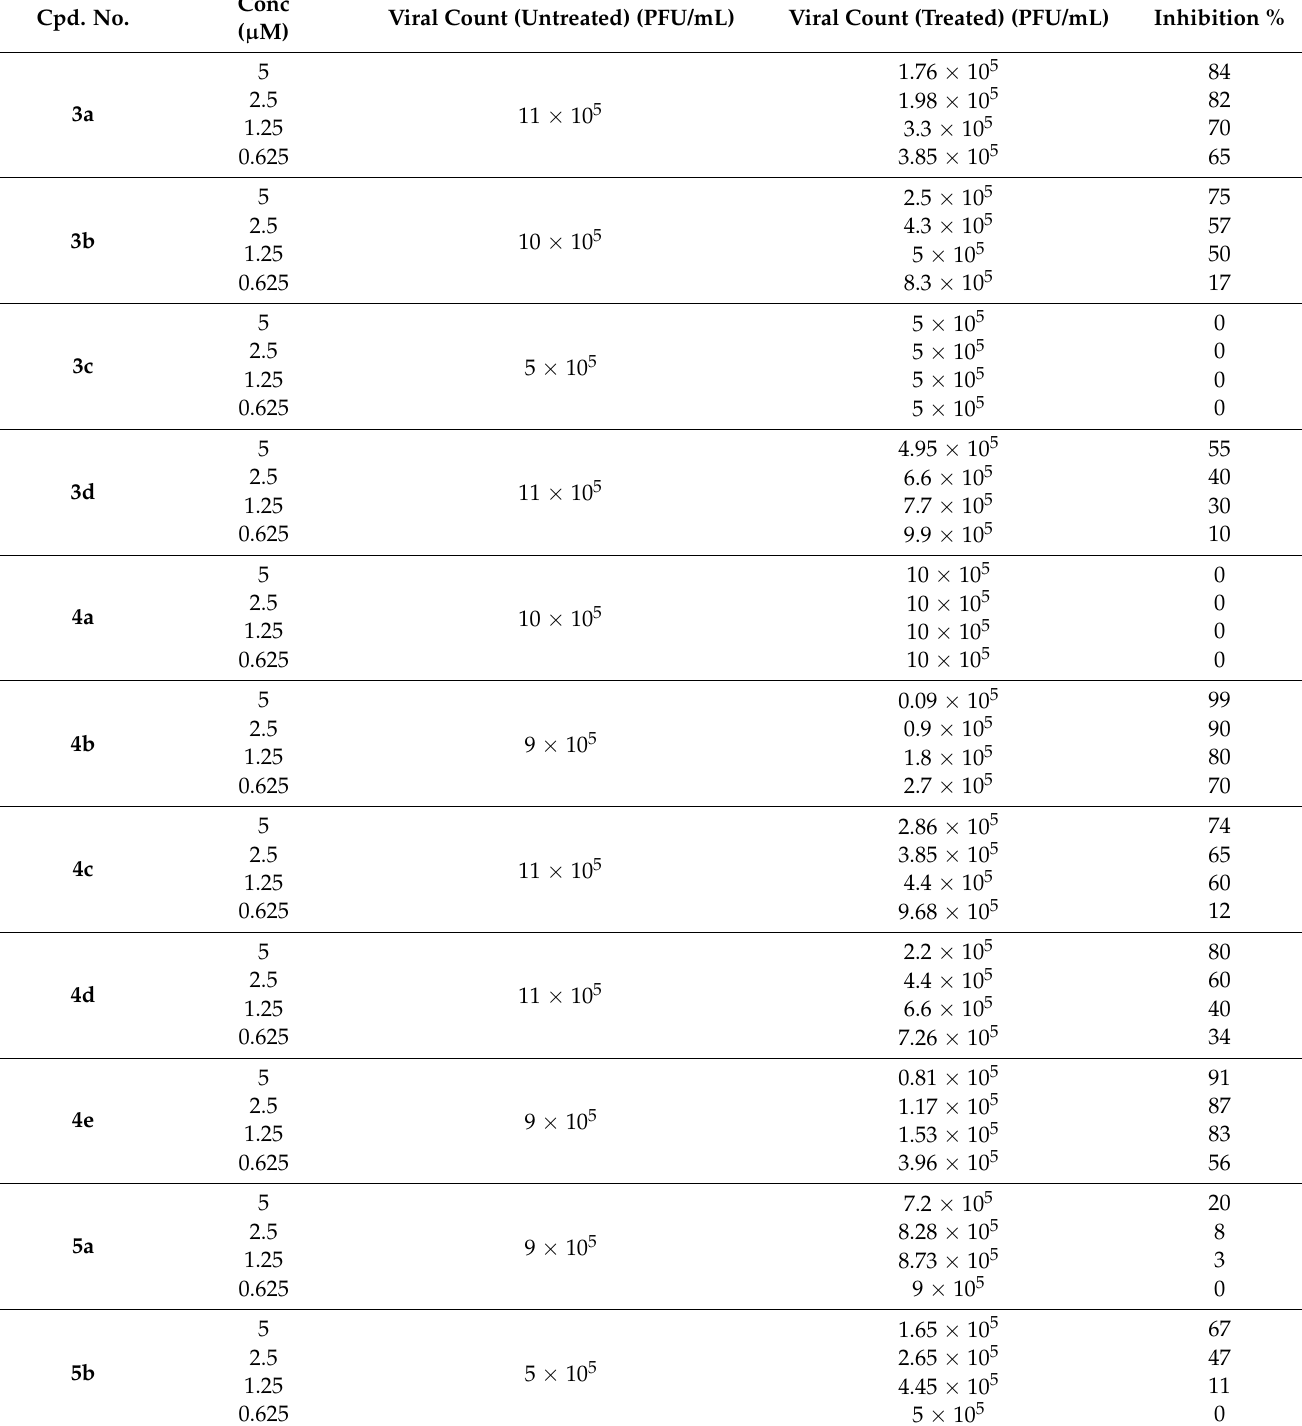
Table 2. Inhibition % of the compounds 3a – c , 4a – e , 5a – e , and Chloroquine as a reference drug. Cpd.